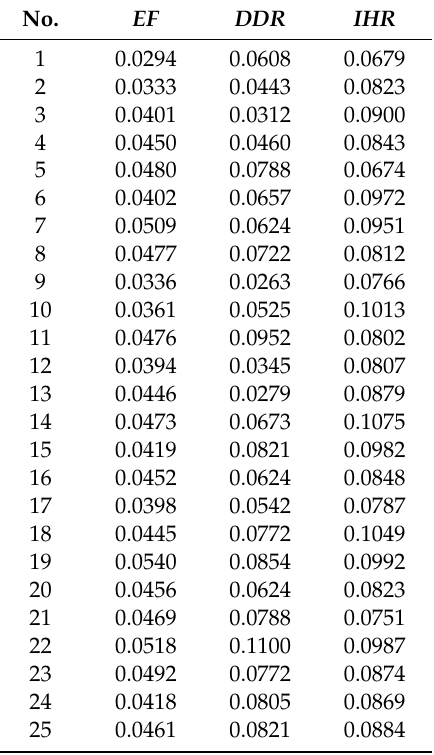
Table 9. Normalized weighted